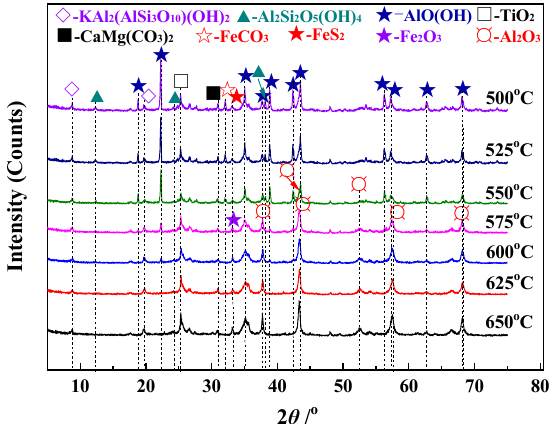
Figure 10. XRD patterns of roasted high-sulfur bauxite at different temperatures.